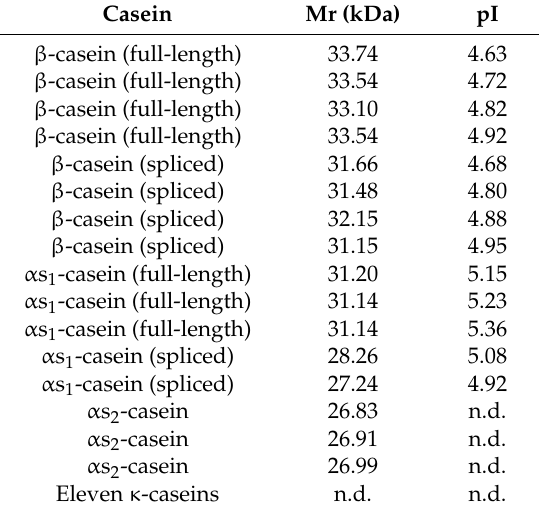
Table 7. Donkey milk casein components. The data reported in this table were obtained from: [38,40,41].